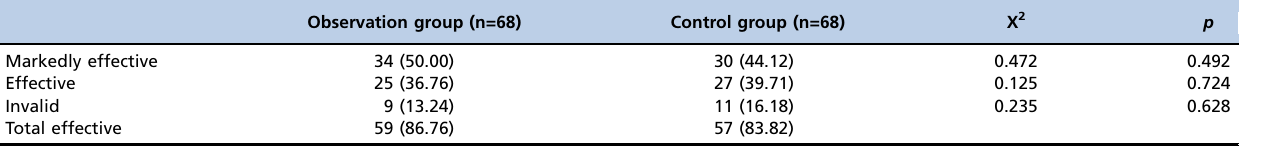
Table 4 - Efficacy evaluation [n